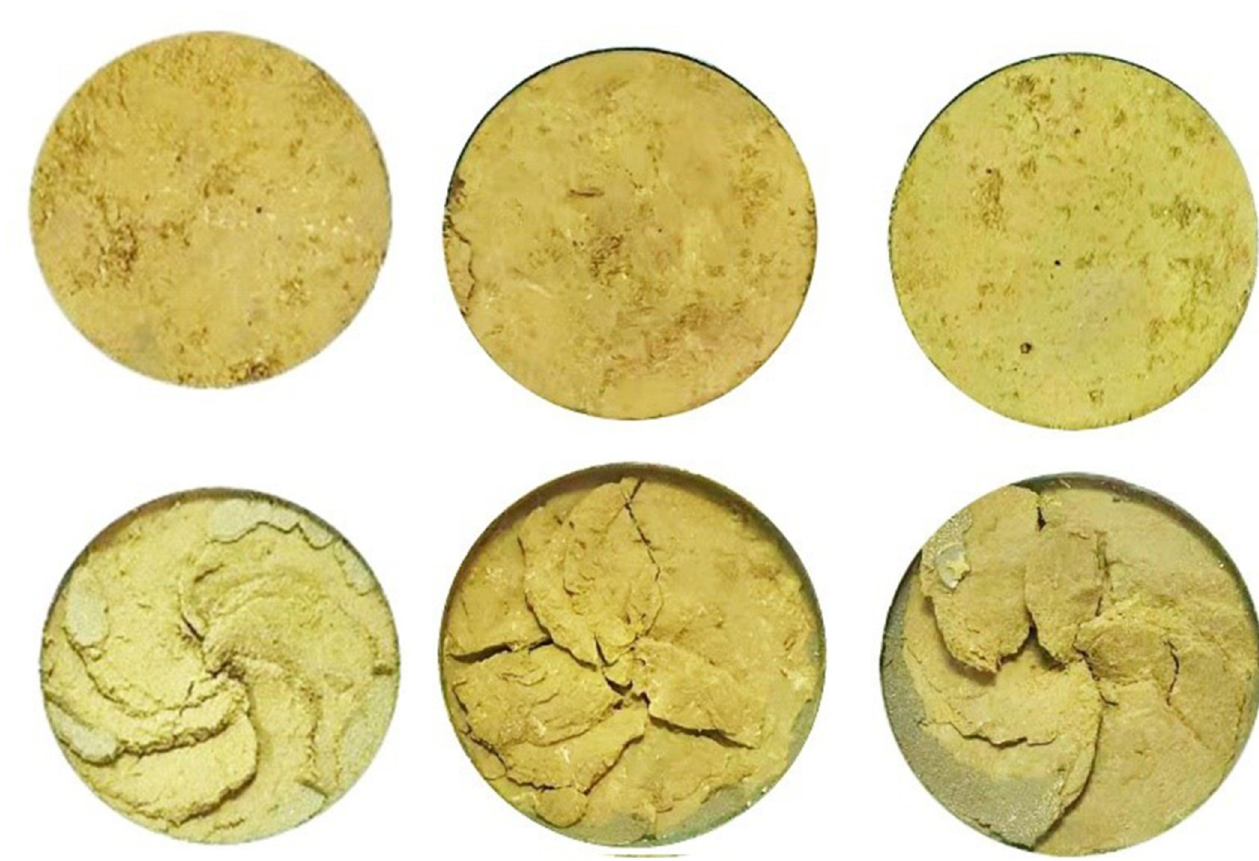
Fig 9. Comparison of the shear surface morphology of 4 # - 6 # undisturbed loess specimen before and after the test. (A) 4 # w = 16%. (B) 5 # w = 19%. (C) 6 # w =